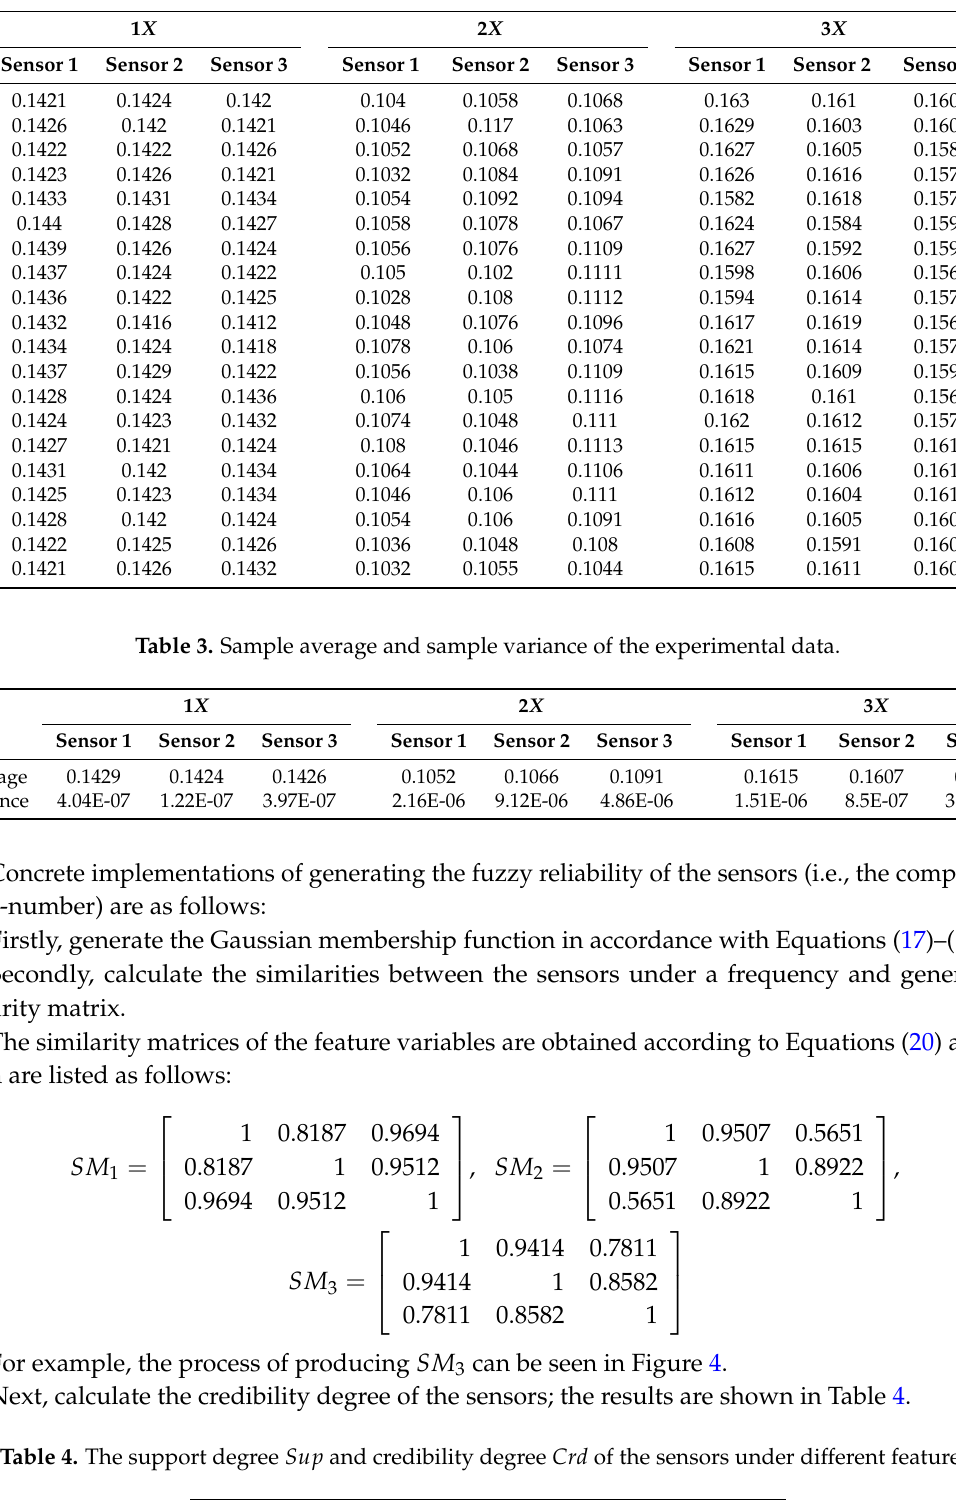
Table 2. Experimental data of the test sample [54].